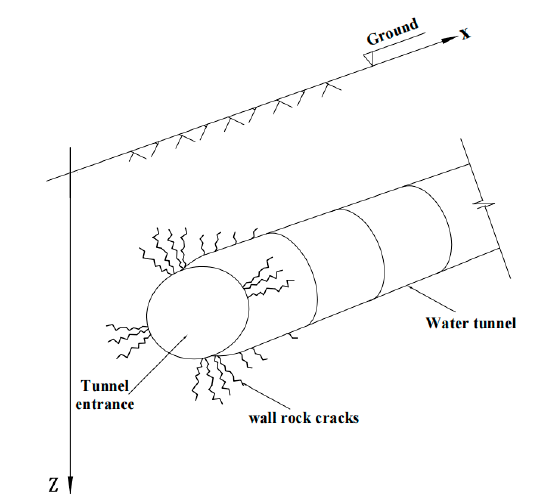
Figure 10. The failure mechanism of hydraulic tunnels in cold regions under frost heaving force. ( a ) Initial state of hydraulic tunnel in cold regions. ( b ) The state of hydraulic tunnel after destruction in cold regions.